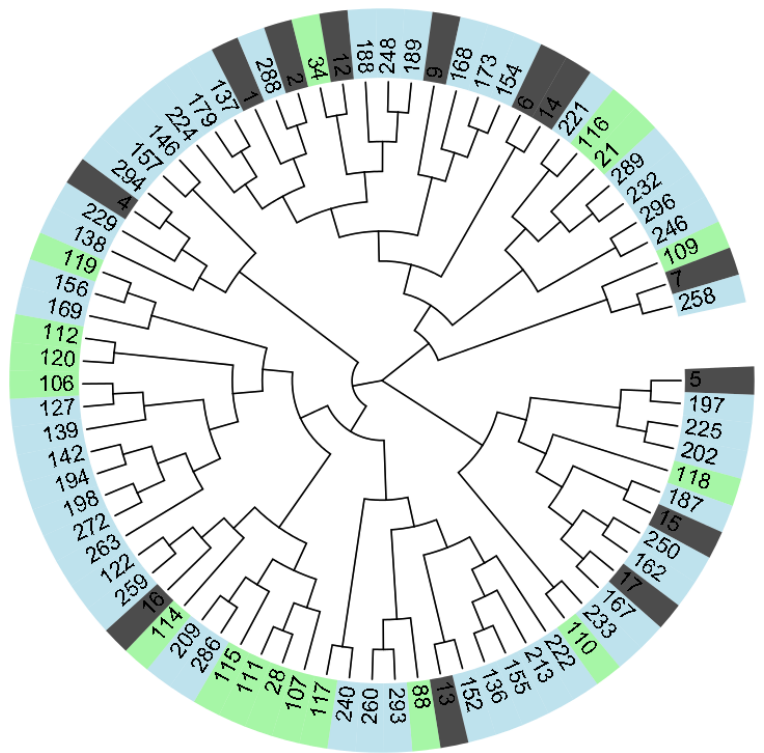
Figure 5. Genetic relationships among 80 pear genotypes revealed by a UPGMA dendrogram, based on nine SSR markers. The dark gray color indicates 13 species of Pyrus , the light green color 17 Romanian cultivars, and the light blue color 50 non-Romanian cultivars from the international assortment. Their codes (number) correspond to the names of the genotypes in Table 1 ( Pyrus species), Table 2 (Romanian cultivars), and Table 3 (non-Romanian cultivars).